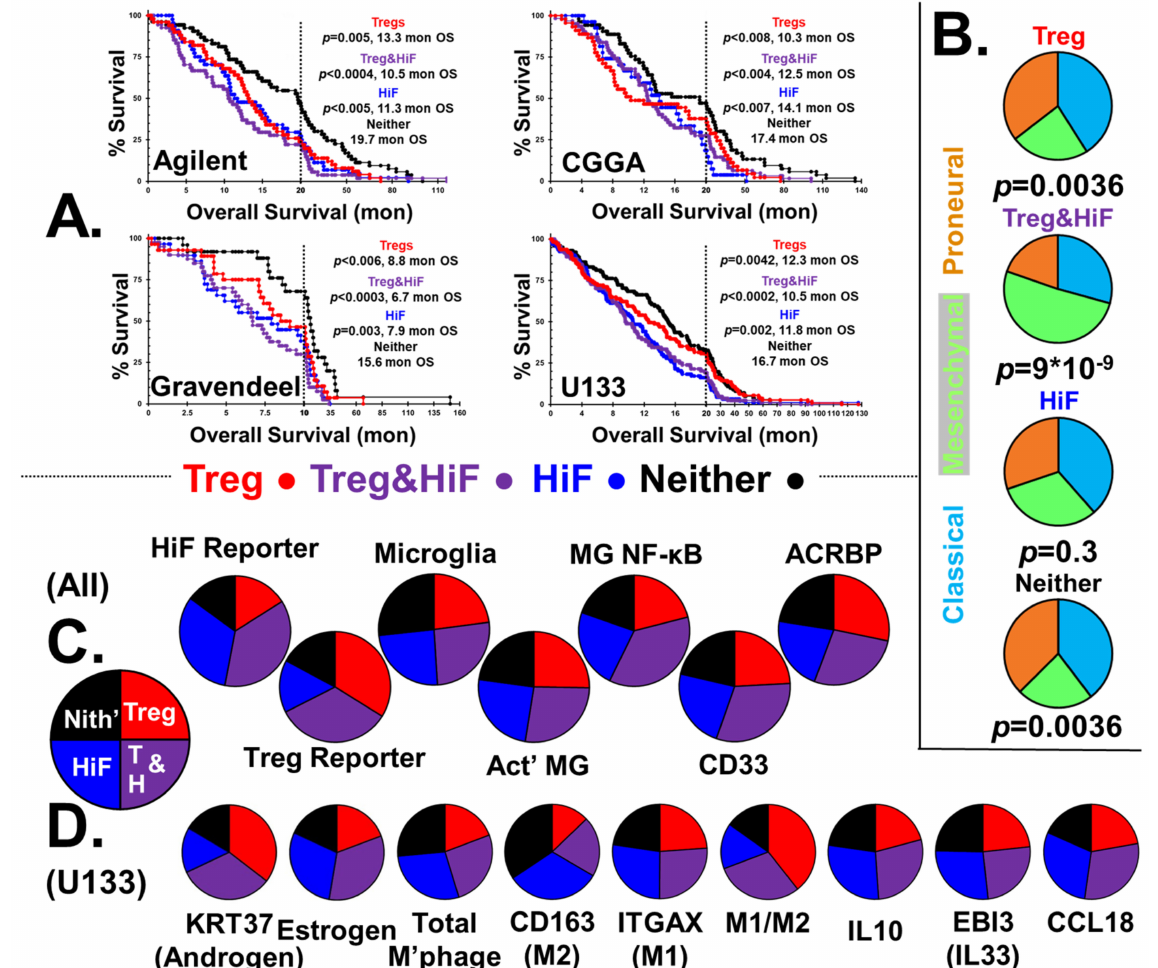
Figure 1. GBM Patient infiltrating Tregs and HiF Status: Outcome and Characteristics. ( A ) Color-coded Kaplan–Meier survival curves of GBM patients stratified for high Treg (red), high HiF (blue), high Treg&HiF (violet), and low Treg&HiF, known as ‘neither’ (black), Agilent, CGGA and Gravendeel and U133 databases. All p values are statistically significant, p < 0.05, when compared to the ‘neither’ group, and median overall survival is indicated in months. ( B ) The distribution of GBM subtypes in the four stratified groups, compared with the global distribution (37% classical, 32% mesenchymal, and 31% proneural), n = 892, as pie charts. Pie charts are color-coded with classical (light blue), mesenchymal (light green) and proneural (burnt orange). p values calculated from utilizing the χ 2 -test are shown. ( C ) Pie charts indicating seven markers of interest, n = 892, from normalized transcripts reporting medians. From left to right; HiF and Treg gene baskets validate stratification methodology. Total microglia (MG) are highest in normoxic tumors without Tregs, whereas both inflammation and NF-kB activation markers are elevated in HiF tumors. Myeloid cell marker CD33 is elevated in hypoxic tumors. ACRBP , which cross-correlates with other sperm/testicular-specific proteins, correlates with RORC-Treg infiltration. p < 0.05 in all cases utilizing t -tests. ( D ) Data from U133 database, examining sex steroid and macrophage phenotypes in stratified groups in the form of pie charts. Androgen reportage ( KRT37 transcript levels) associates with RORC-Tregs, whereas hypoxia correlates with estrogen reportage. Macrophage infiltration ( ITGAM and CD68 ) tracks hypoxia, and M2/M1 polarization markers CD163 and ITGAX indicate RORC-Tregs appear to drive M1 > M2. IL10 , EBI3 and CCL18 levels are biased toward hypoxic tumors. p < 0.02 in all cases utilizing t -tests. Individual t -test results in Supplemental Table